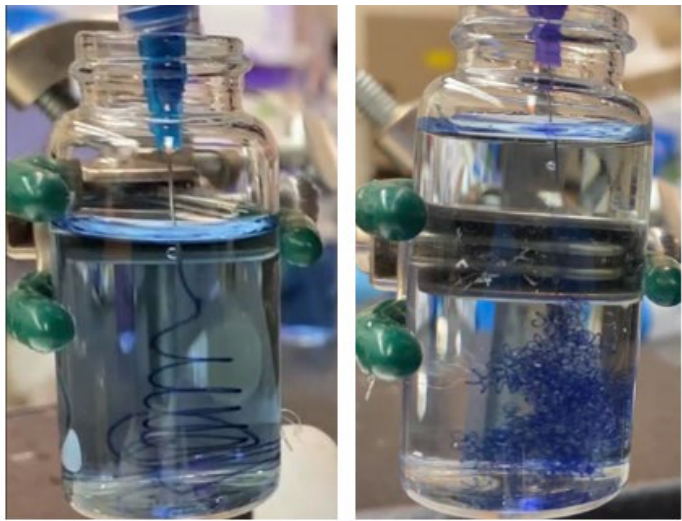
Figure 6. The observed topology of the fiber deposited via immersed microfluidic spinning. In both cases 1 mL/min volumetric flow rate of the sodium alginate was used. The left picture represents spinning of 6 wt % sodium alginate with a 20-gage needle and the right picture presents the spinning of 4 wt % sodium alginate with 25-gage needle.